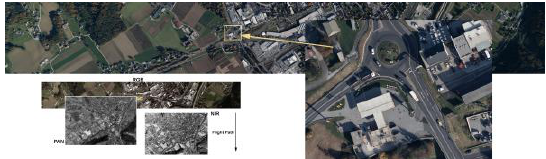
Fig. 5 b: Measured lens temperatures during the calibration set-up. The temperature range of each lens for the entire set is at 1,2°C. The standard deviation of the set of 140 measurements for each individual lens system is in the range of 0,3°C. The mean temperature value from each lens is stored and reused for the postprocessing of each individual production image.